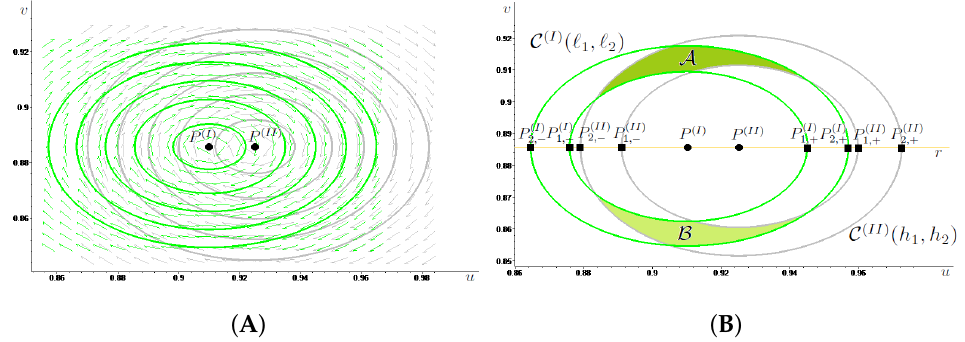
Figure 1. In ( A ) we draw in green some energy level lines associated with System ( I ) , surrounding P ( I ) , and in gray some energy level lines associated with System ( II ) , surrounding P ( II ) , together with the corresponding phase portrait. In ( B ), we illustrate Definition 1, showing how to obtain two linked together annuli by suitably choosing two level lines for each system. In particular, we